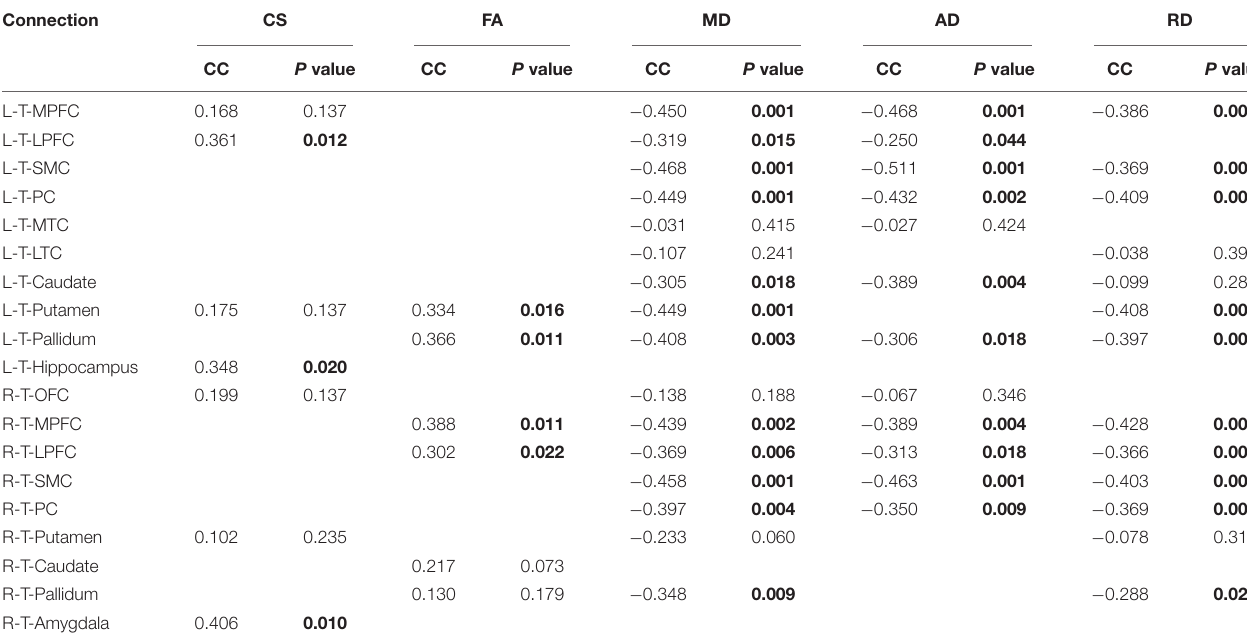
TABLE 2 | Correlations between thalamic connectivity measurements and the